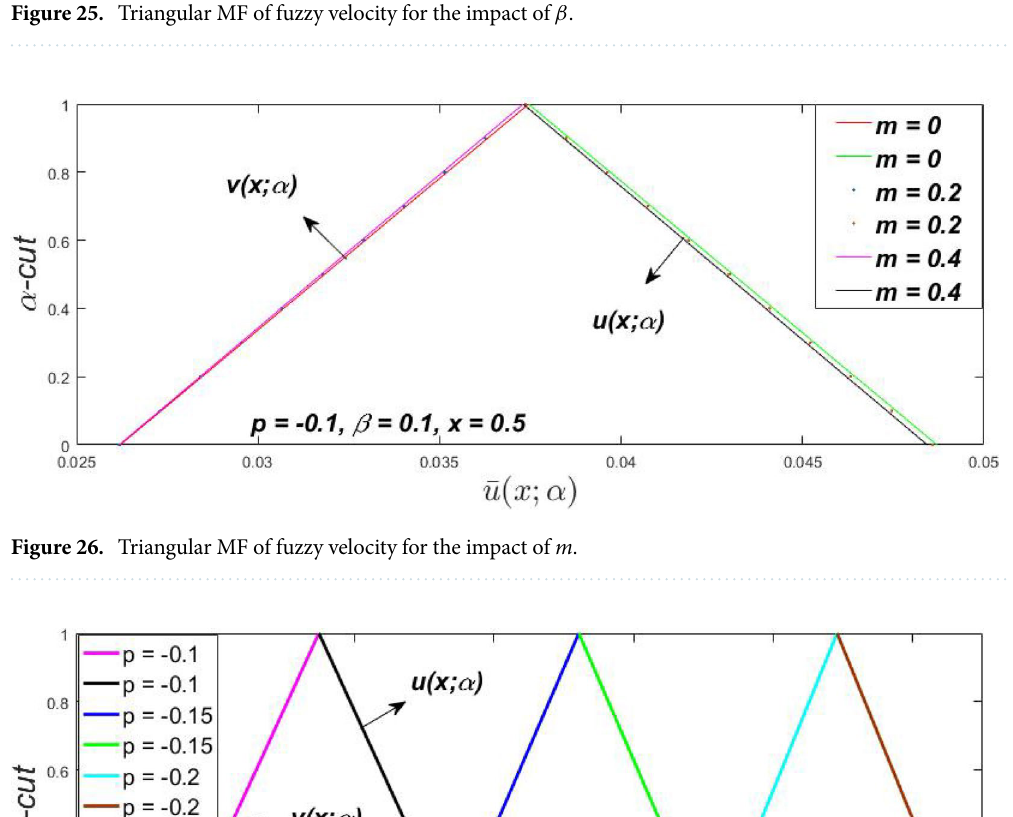
Figure 25. Triangular MF of fuzzy velocity for the impact of β .